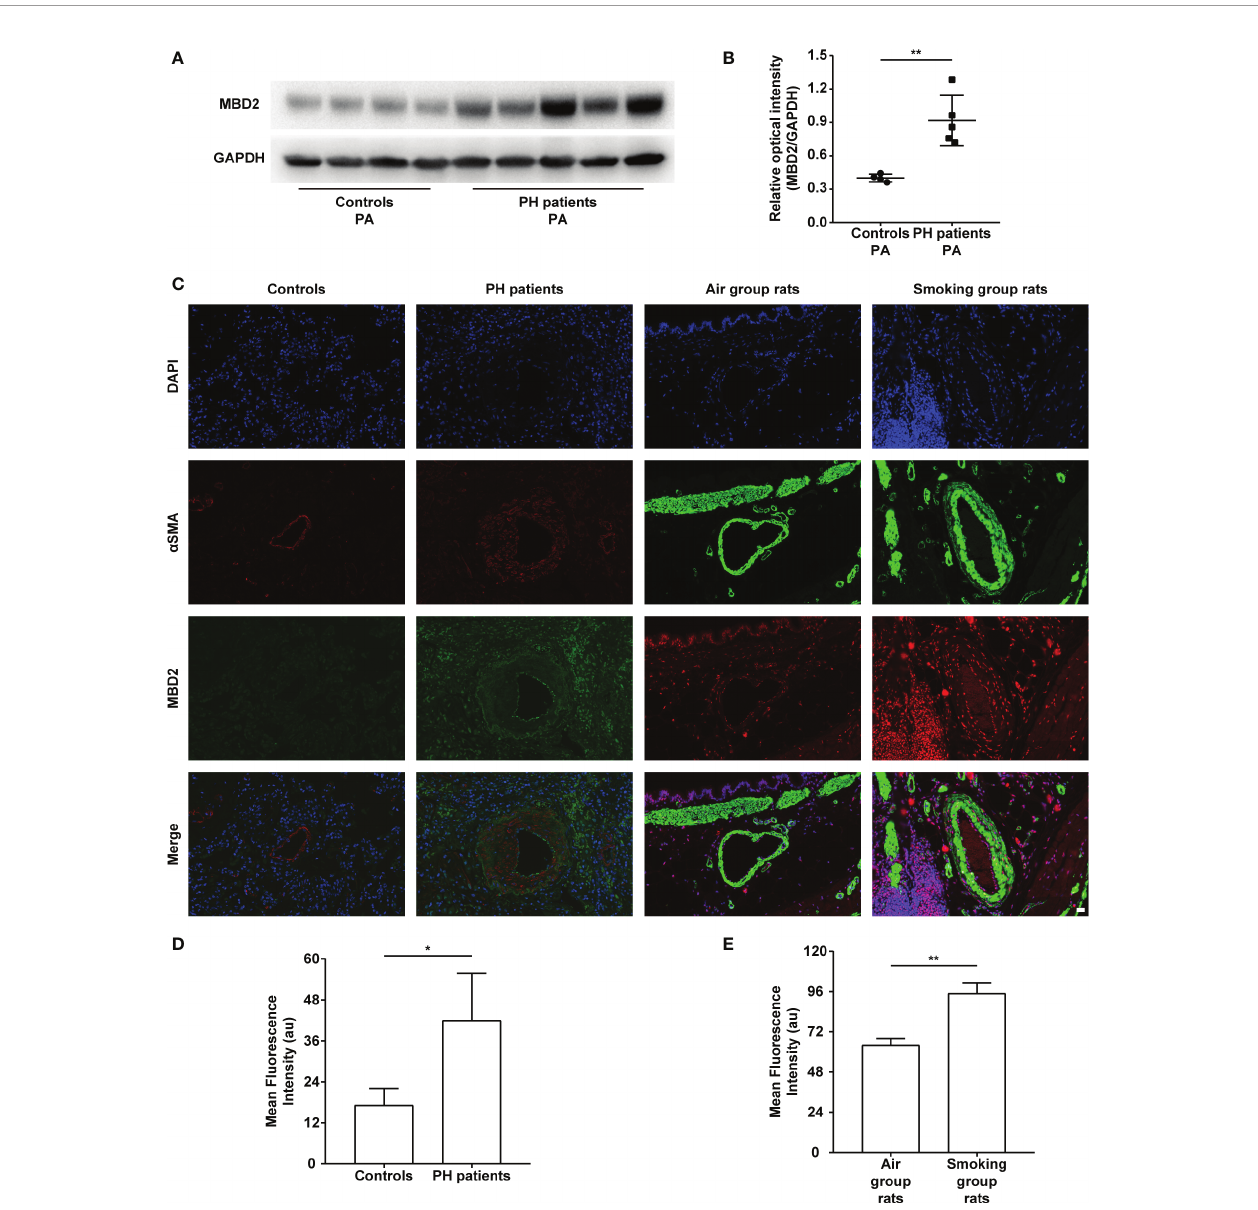
FIGURE 1 | The increase in MBD2 protein in cigarette smoke (CS)-induced pulmonary hypertension (PH). (A) Representative Western blot images of MBD2 in human pulmonary arteries. (B) Quantitative analysis results of graph A based on the density of the bands (controls, n=4; PH, n=5). (C) Representative results of coimmunostaining of MBD2 and a -SMA in lung sections of the controls or PH groups, and the air group rats or smoking group rats. All images are 400× magni fi cation. Scale bar = 20 m m. (D) Mean fl uorescence intensity of the MBD2 in PAs of the controls or PH groups. (n=3) (E) Mean fl uorescence intensity of the MBD2 in PAs of the air group rats or smoking group rats (n=3). The data are presented as mean ± SD. * P < 0.05, ** P <